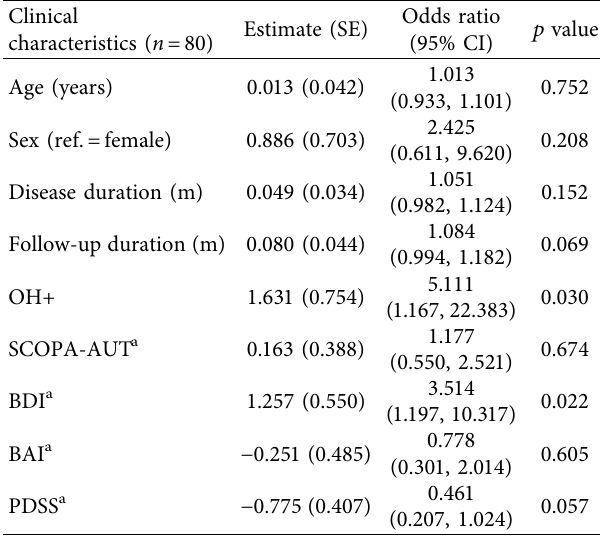
Table 2: Logistic regression analysis to predict fgures in patients with Parkinson’s disease.